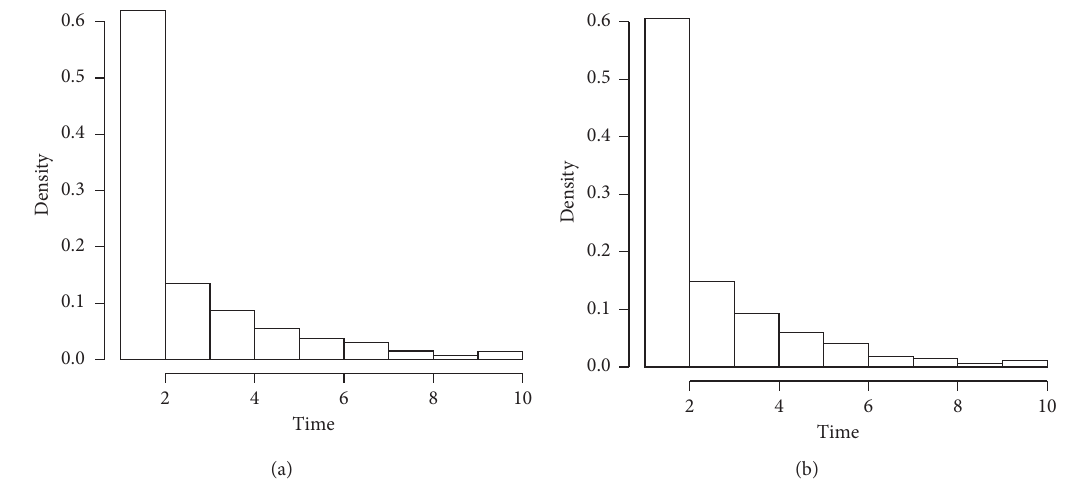
Figure 5: Histogram of the next jump